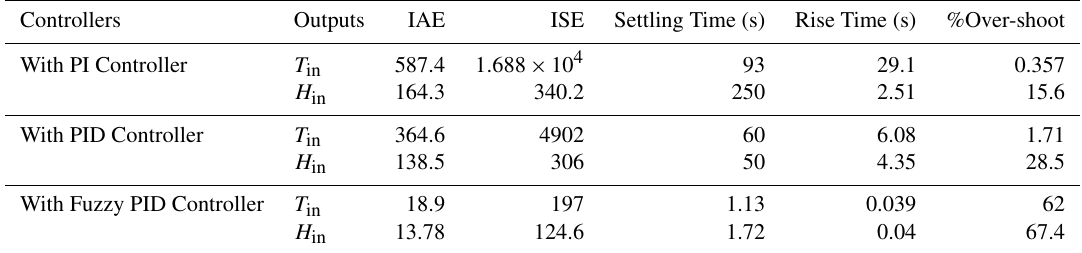
Figure 17. (a) Comparative Analysis of Step Changes in Inlet Temperature T in with Fuzzy PID and PID Controller and (b) Comparative Analysis of Step Changes in Inlet Humidity H in with Fuzzy PID and PID Controller. Table 6. Performance analysis of the greenhouse